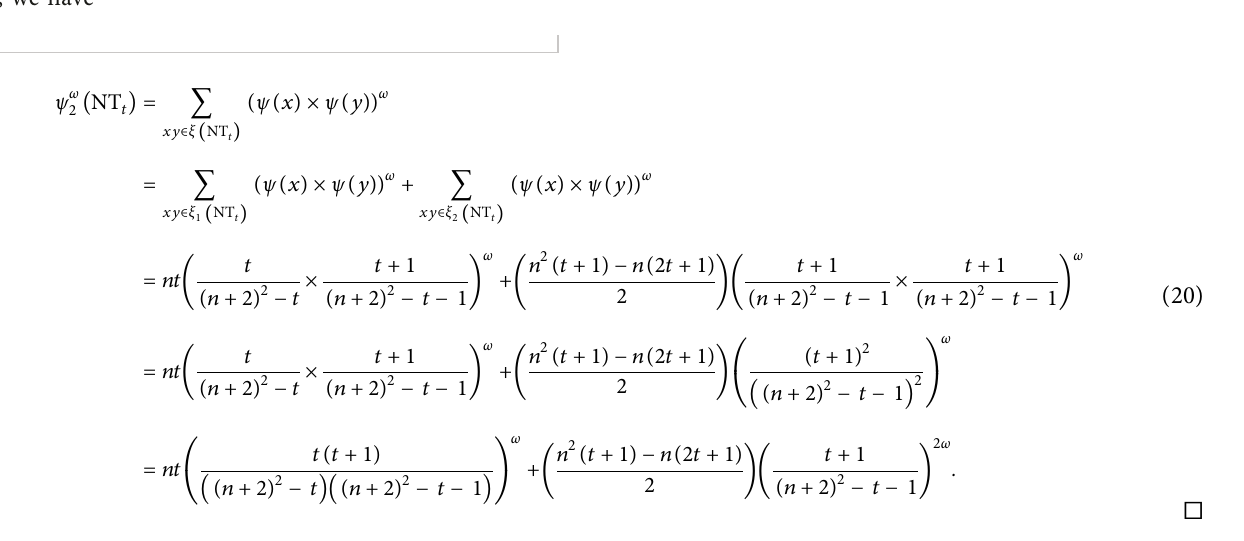
, ψ ω and ψ ω for NT t 1 2